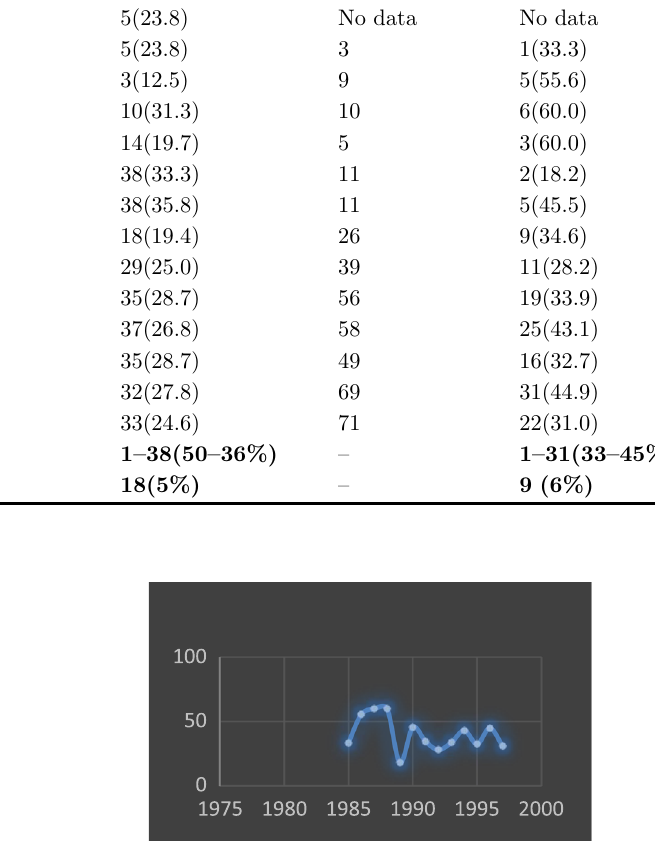
Fig. 4. Trend of WACS passrate_Part II.